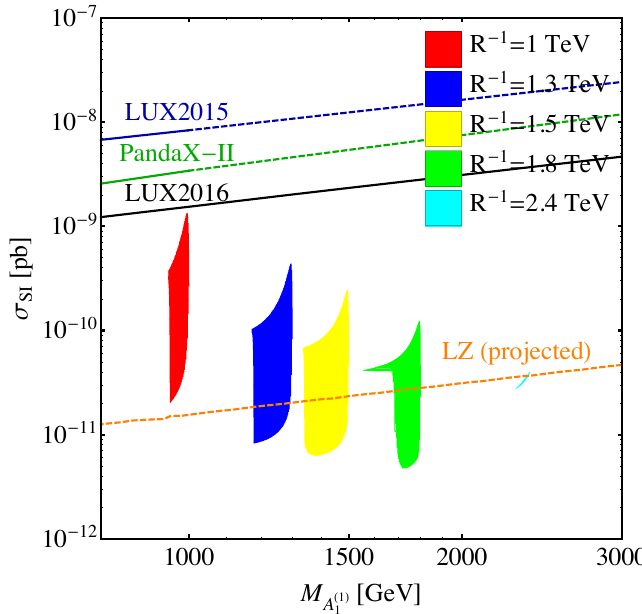
Figure 9 . The expected SI cross sections ( (cid:27) SI ) are plotted for various values of R (cid:0) 1 ranging from 1 TeV to 2.4 TeV. For each R (cid:0) 1 , we vary ( r B =L; r W =L ) within the allowed parameter regions from (cid:12)gure 7 in order to obtain the predicted regions of (cid:27) SI . Current exclusion limits are set by LUX [74] (dark blue and black) and PandaX-II [75] (dark green). The expected sensitivity of LZ (orange) is found in ref. [73]. The LZ projected sensitivity would cover the entire remaining parameter space for R (cid:0) 1 = 1 TeV. A large part of the parameter space in ( r B =L; r W =L ) is within the testable range for a larger value of R (cid:0) 1 ,